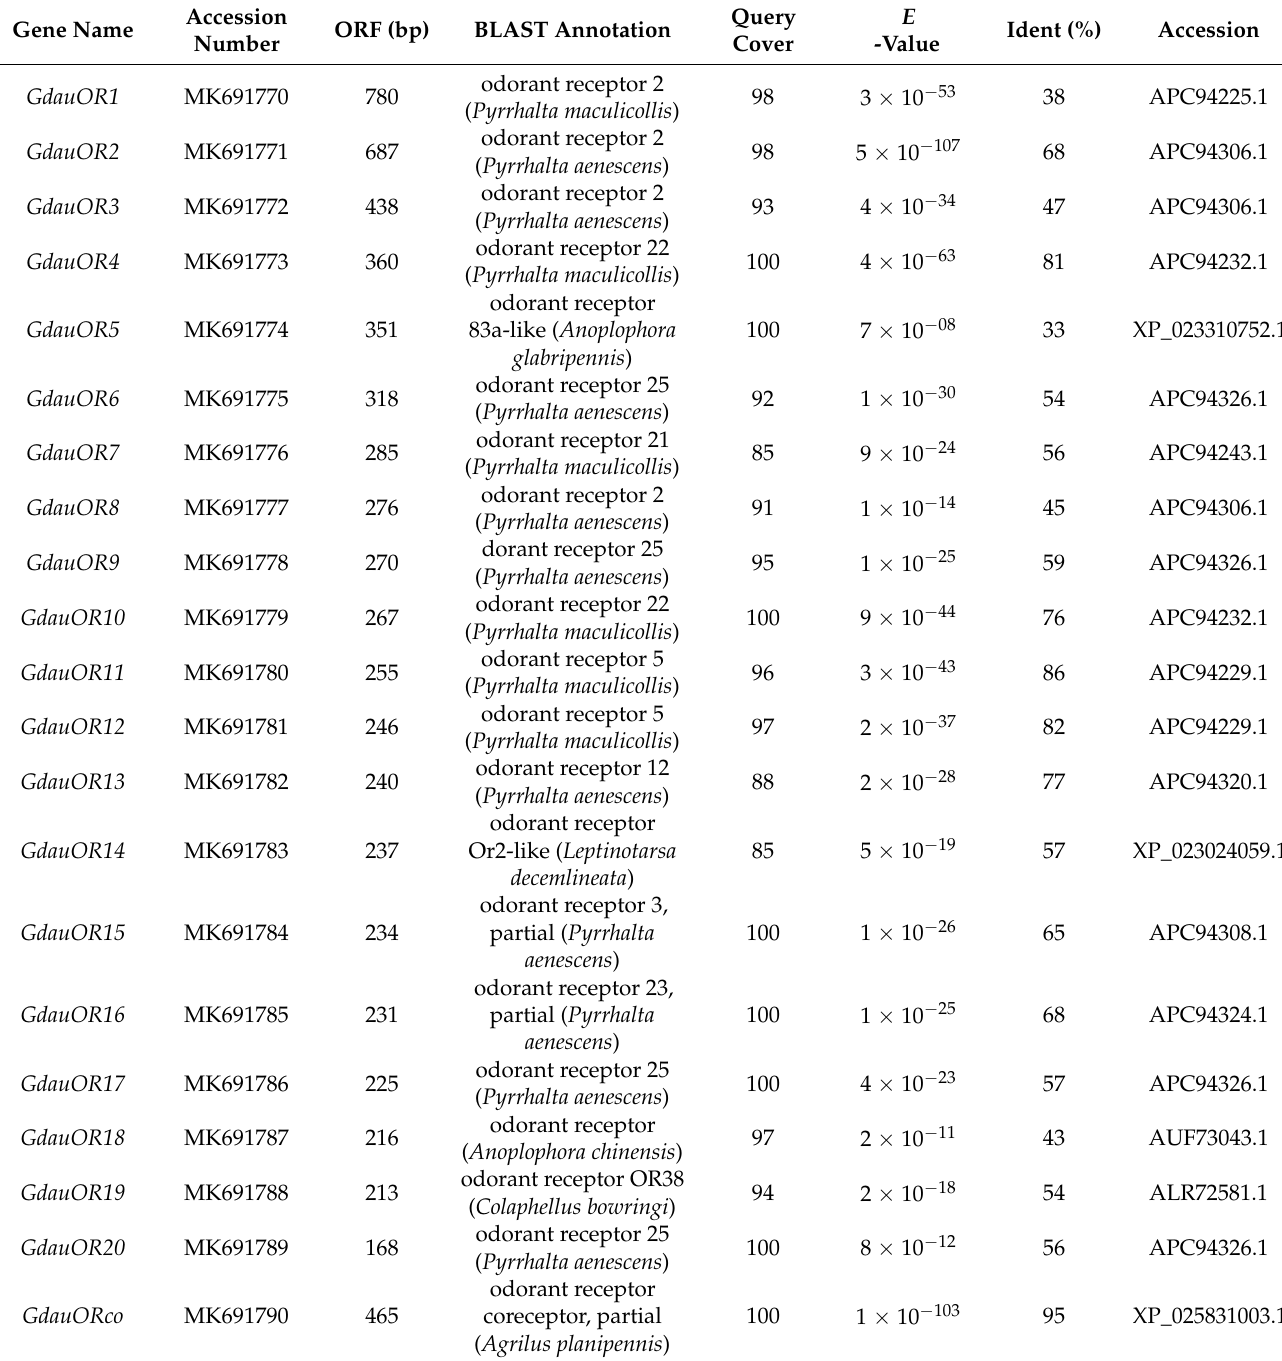
Table 2. List of OR genes in G. daurica